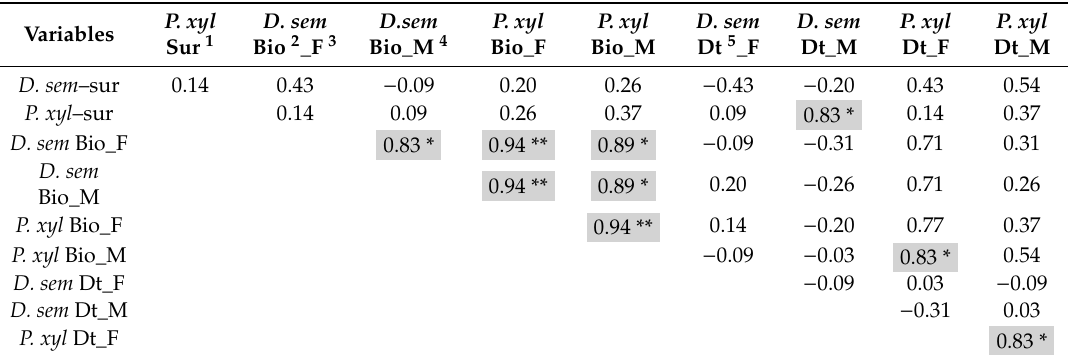
Table 1. Spearman’s correlation coe ffi cients on performance variables (survival, biomass, and development time) of the six Plutella xylostella populations when they were unparasitized ( P. xyl ) or parasitized by Diadegma semiclausum ( D. sem